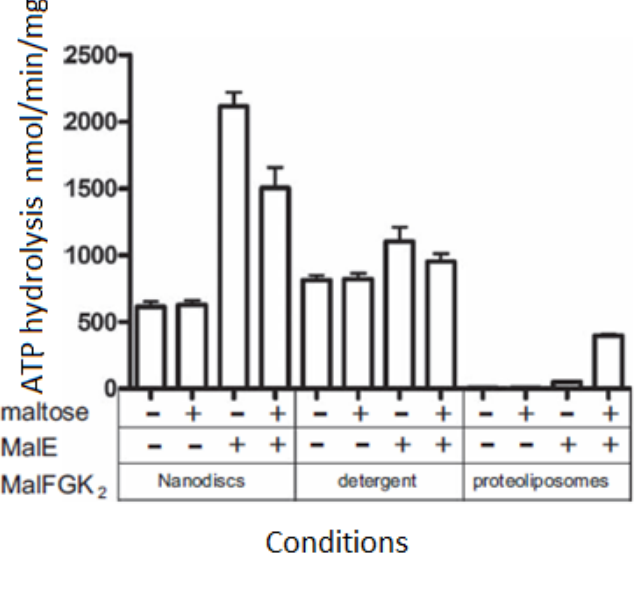
Figure 7. The ATPase activity of MalFGK2 was measured in nanodisc, detergent solubilized conditions and proteoliposomes in the presence of MalE or maltose